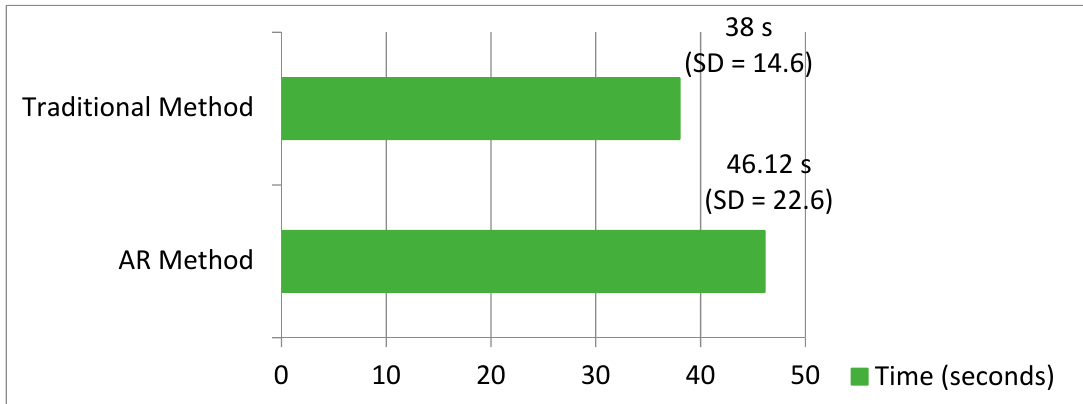
Figure 5. Comparison of augmented reality (AR) methodology and traditional methodology: total mean times (seconds) for tasks.